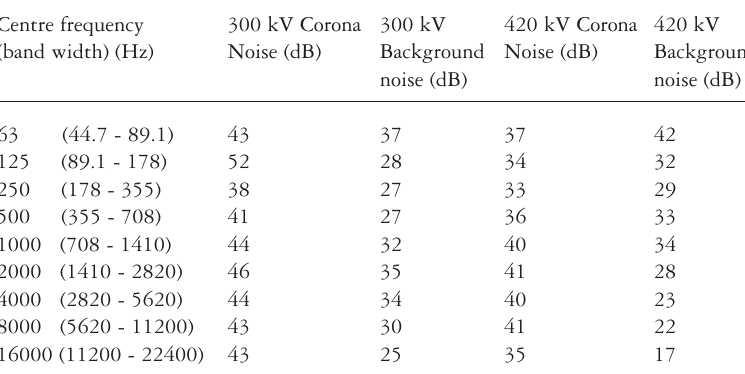
Table 1. Measurements of background noise and corona noise from 300 kV and 420 kV power lines in rainy weather at 0 - 4 o C. Measured in octave bands 1 m above ground and about 15 m from the